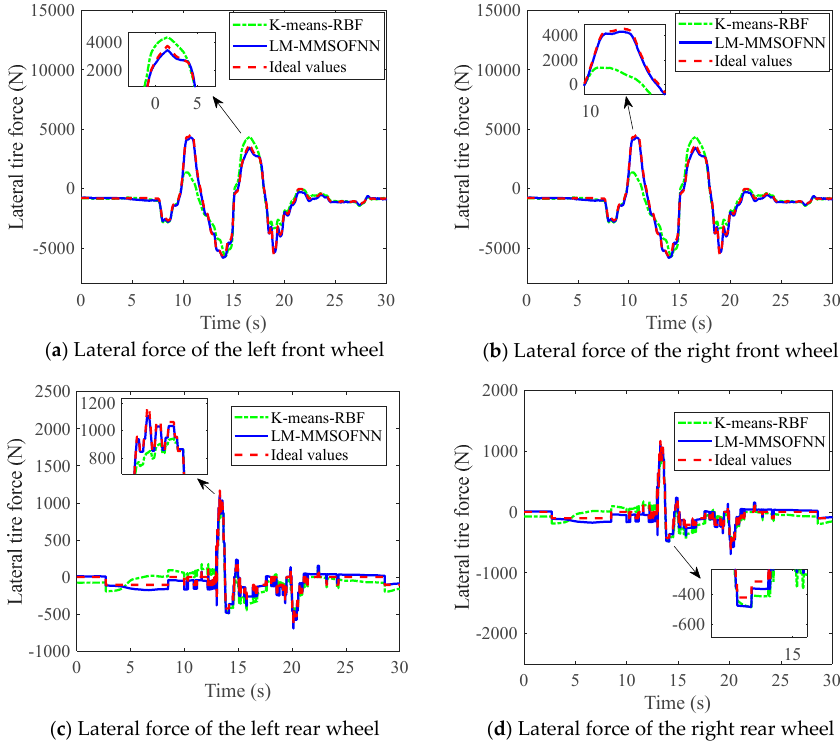
( d ) Longitudinal force of the right rear wheel Figure 19. The longitudinal tire force of four wheels. Table 8. Longitudinal tire force estimation errors of LM-MMSOFNN and K-means-RBF. F xfl